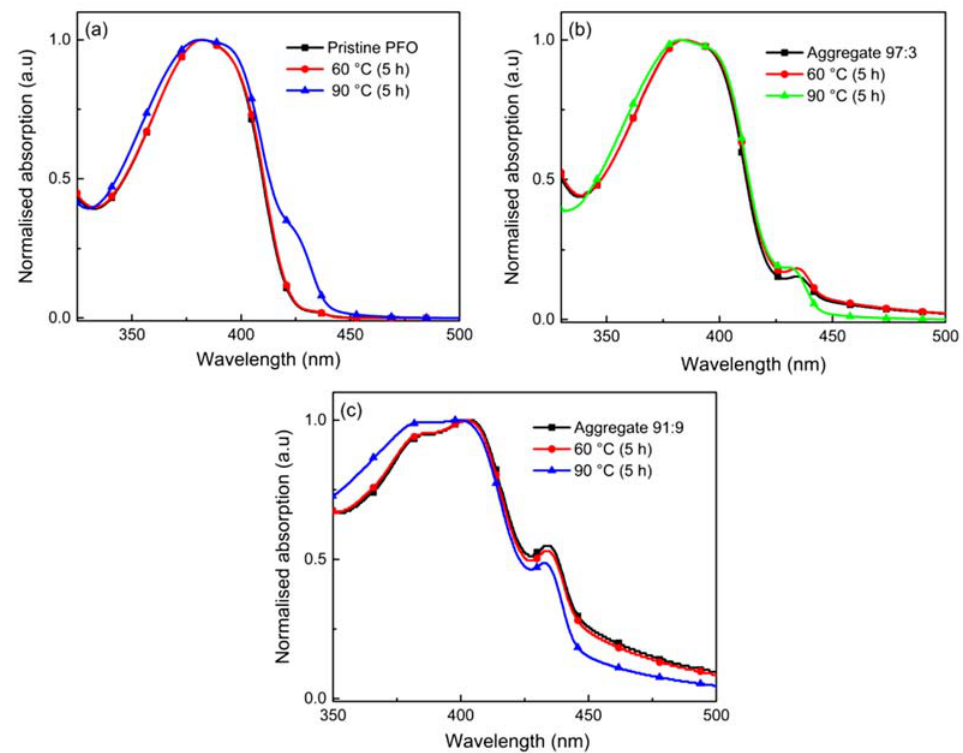
Figure 3. UV-Vis absorption spectra of ( a ) pristine PFO films and aggregated PFO films from chloroform/methanol with the ratio of ( b ) 97:3 and ( c ) 91:9, before and after the thermal degradation test.